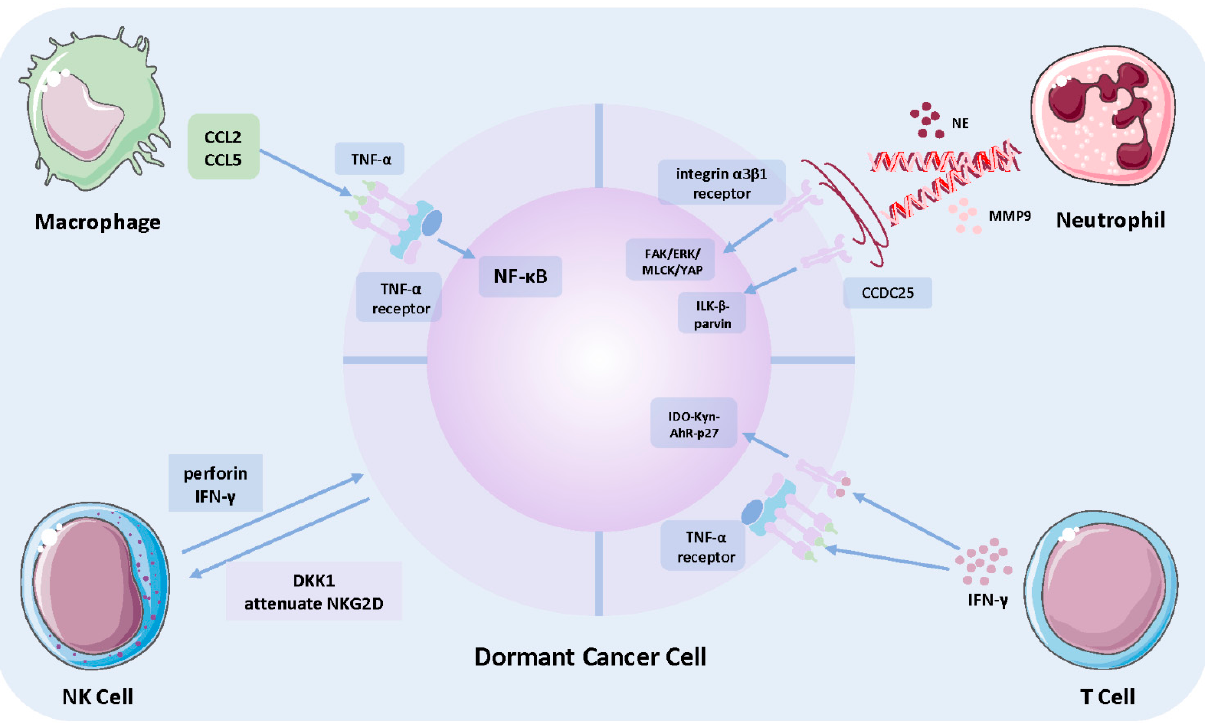
Figure 3. Crosstalk between dormant cancer cells and immune components. The mechanism and effect of tumor-associated macrophage, tumor-associated neutrophil, NK cells, and T cells on dormancy varies. (1) Crosstalk with Macrophage: CCL2 and CCL5 in TME recruit macrophages and polarize them into tumor-permissive M2 TAM, leading to dormancy